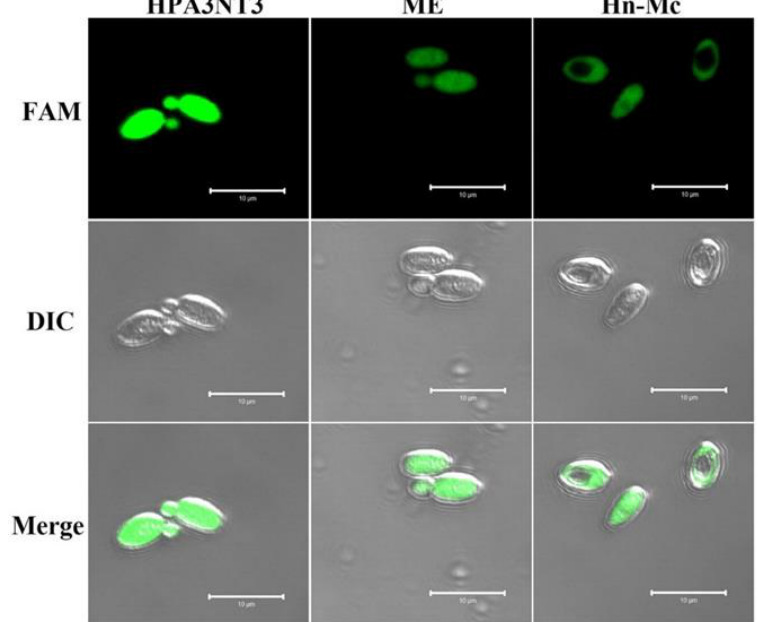
Figure 2. Cellular distributions of HPA3NT3, ME, and Hn-Mc in C. tropicalis cells. After C. tropicalis cells with FAM labeled-HPA3NT3, ME, and Hn-Mc were incubated for 1 h, the fungal cells were washed and observed using a confocal laser scanning microscope.